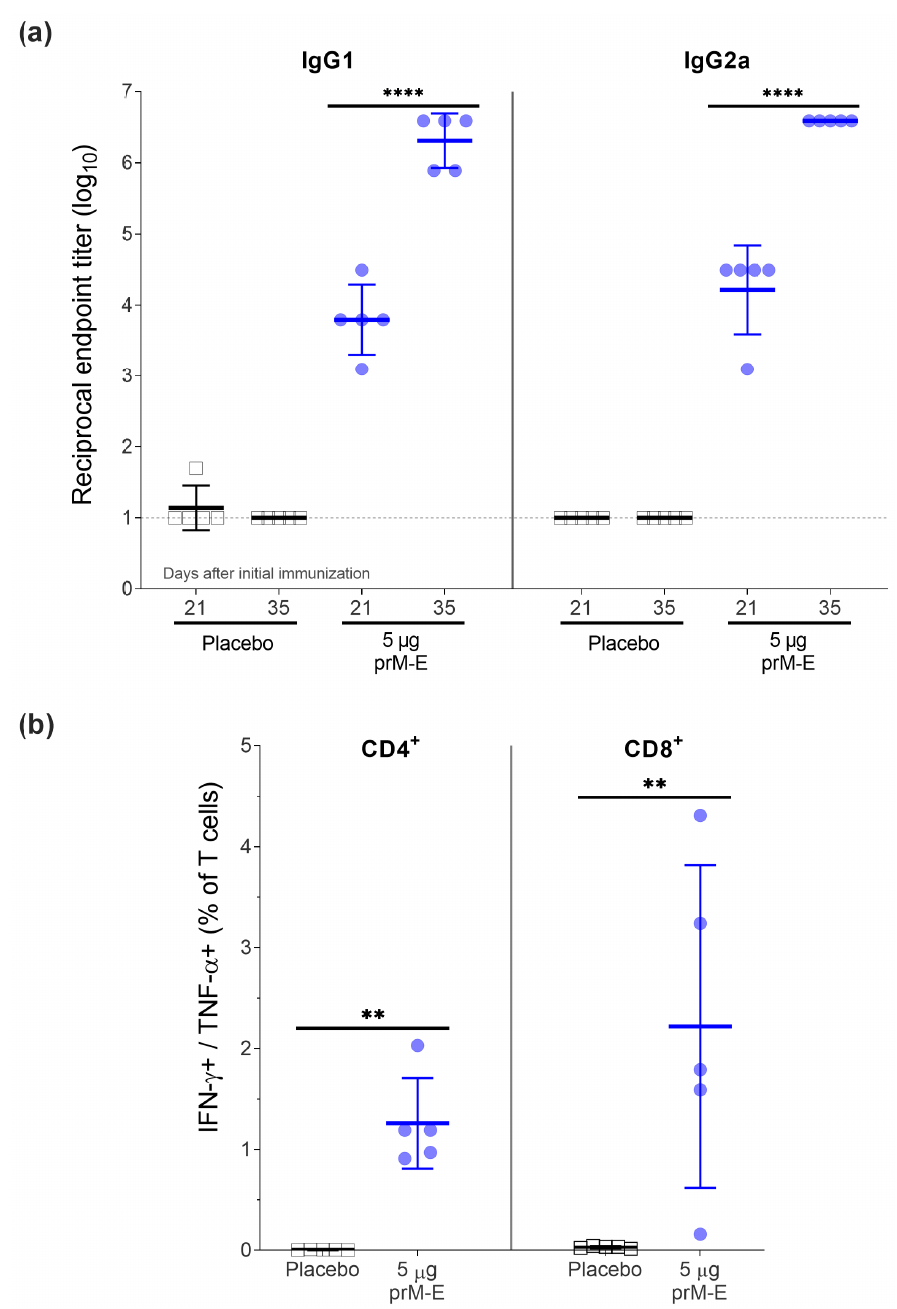
Figure 2. ZIKV prM–E mRNA-LNP vaccine candidate induces high titers of IgG1 and IgG2a antibod- ies and T-cell responses in BALB/c mice ( n = 5 per group) that received two doses of 5 µ g of ZIKV prM–E (circle; blue) or placebo injection of NaCl buffer (open square; black) 21 days apart. Mice were euthanized for splenocyte isolation on day 35. ( a ) Profile of IgG1 and IgG2a antibody responses (geometric mean ± geometric SD) measured in serum before the second immunization (day 21) and before euthanasia (day 35). ( b ) Frequency of IFN- γ +/TNF- α + on CD4 + and CD8 + T-cell subsets mea- sured by intracellular cytokine staining 2 weeks after the second immunization (mean ± SD). Raw data used for the figures are available in the Supplementary Materials. Dashed line shows the limit of detection; ** p < 0.01, **** p < 0.0001. Two-way ANOVA followed by Šid á k’s multiple comparisons test was performed for the IgG1 and IgG2a antibody titers. These tests were performed after the data were log-transformed and assessed for normality using a QQ plot. For the T-cell analysis, a Mann–Whitney U test was implemented. All tests were performed using GraphPad